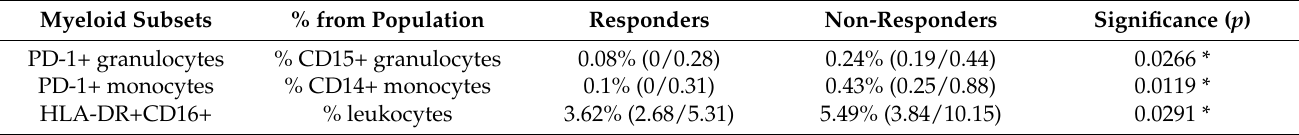
Table 3. Three myeloid subsets associated with treatment failure.